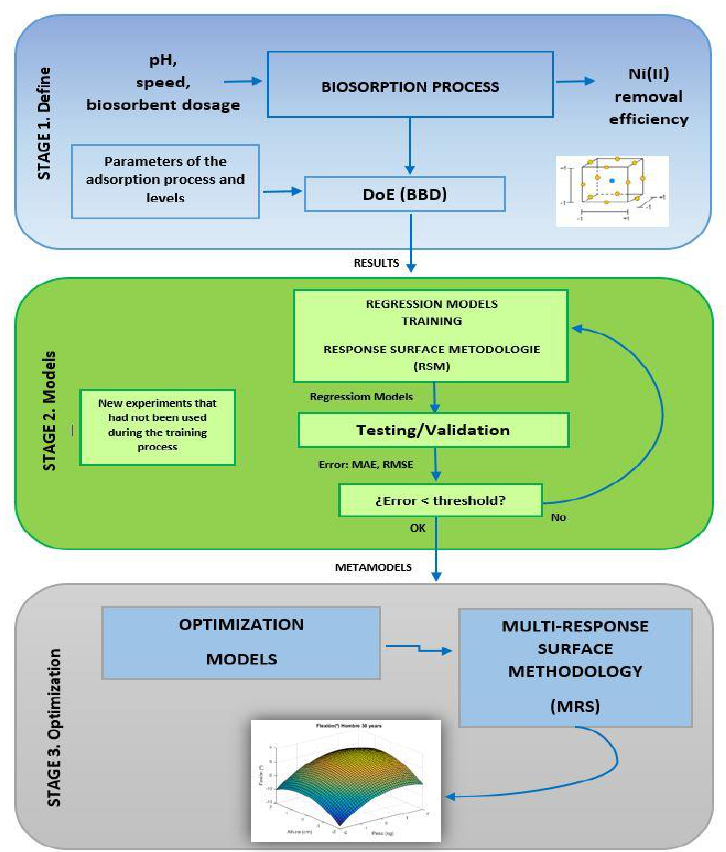
Figure 1. The main stages of the